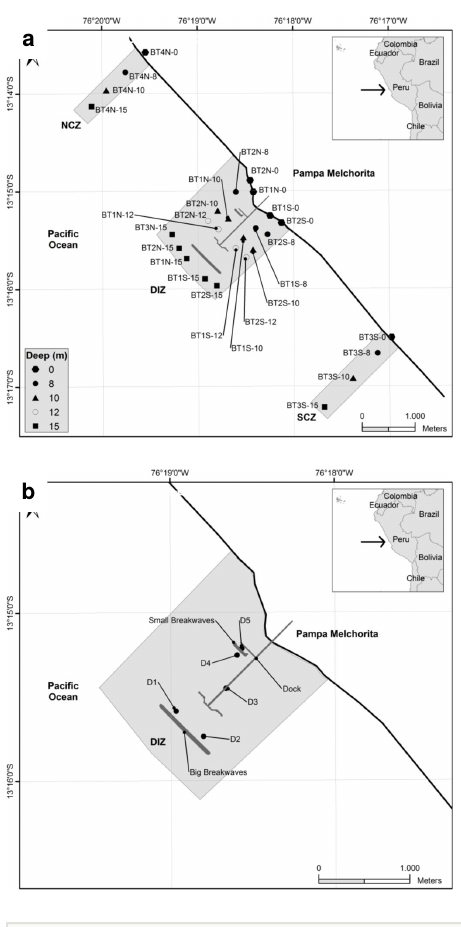
Figure 1. Study area around the PERU LNG marine terminal including location of sampling sites. Sites are identi fi ed by a unique code followed by depth at which that site is located. Grey-shaded area at the centre is the area of direct in fl uence of the marine terminal while grey-shaded areas at the north and south of the terminal are control sampling sites. a : Soft bottom sites. b : Hard bottom